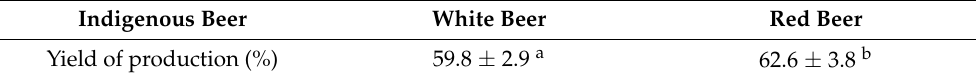
Table 2. Wort yield according to the type of sorghum used for the production of indigenous alcoholic